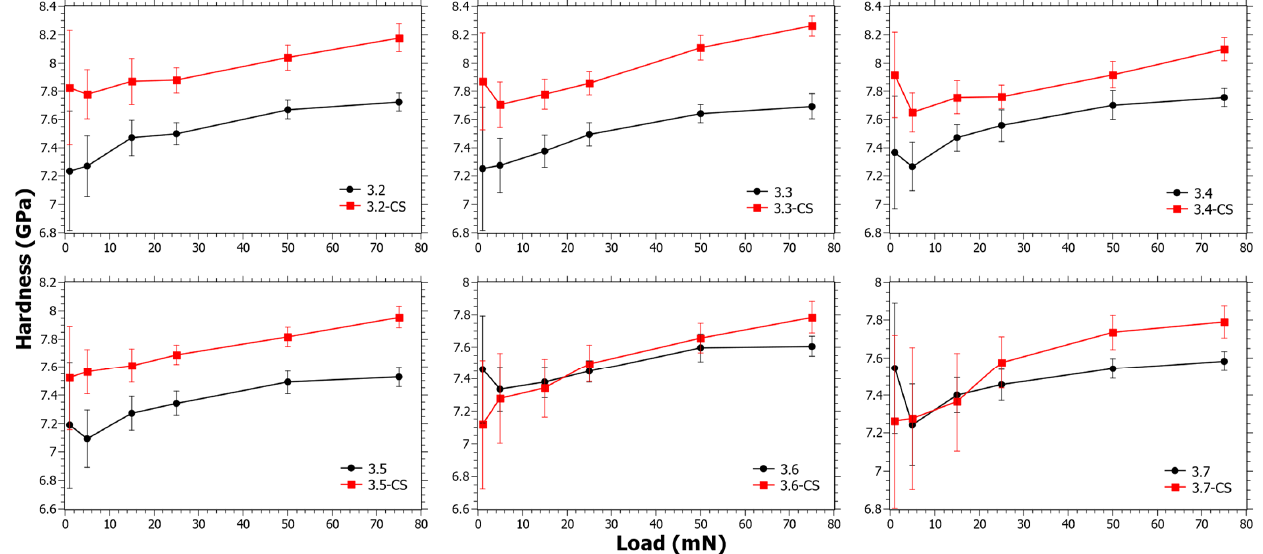
Figure 4. Nano-indentation hardness as a function load for Series 3 before and after chemical strengthening (CS).